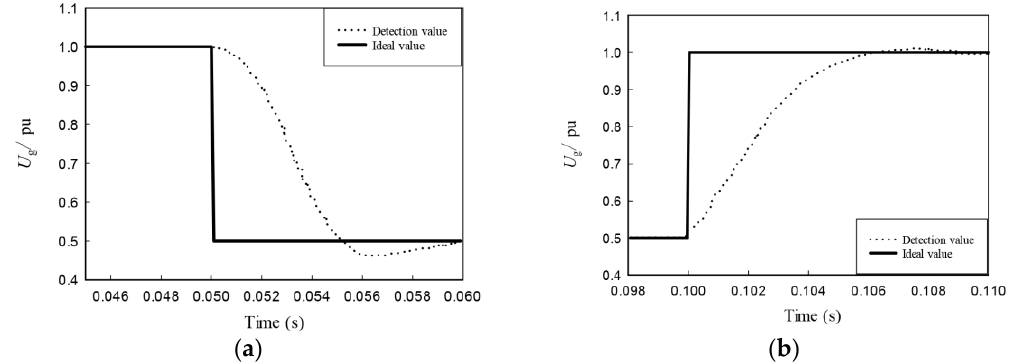
Figure 7. Detected value of fundamental signal: ( a ) Voltage sag initiation process; ( b ) Voltage sag recovery process.